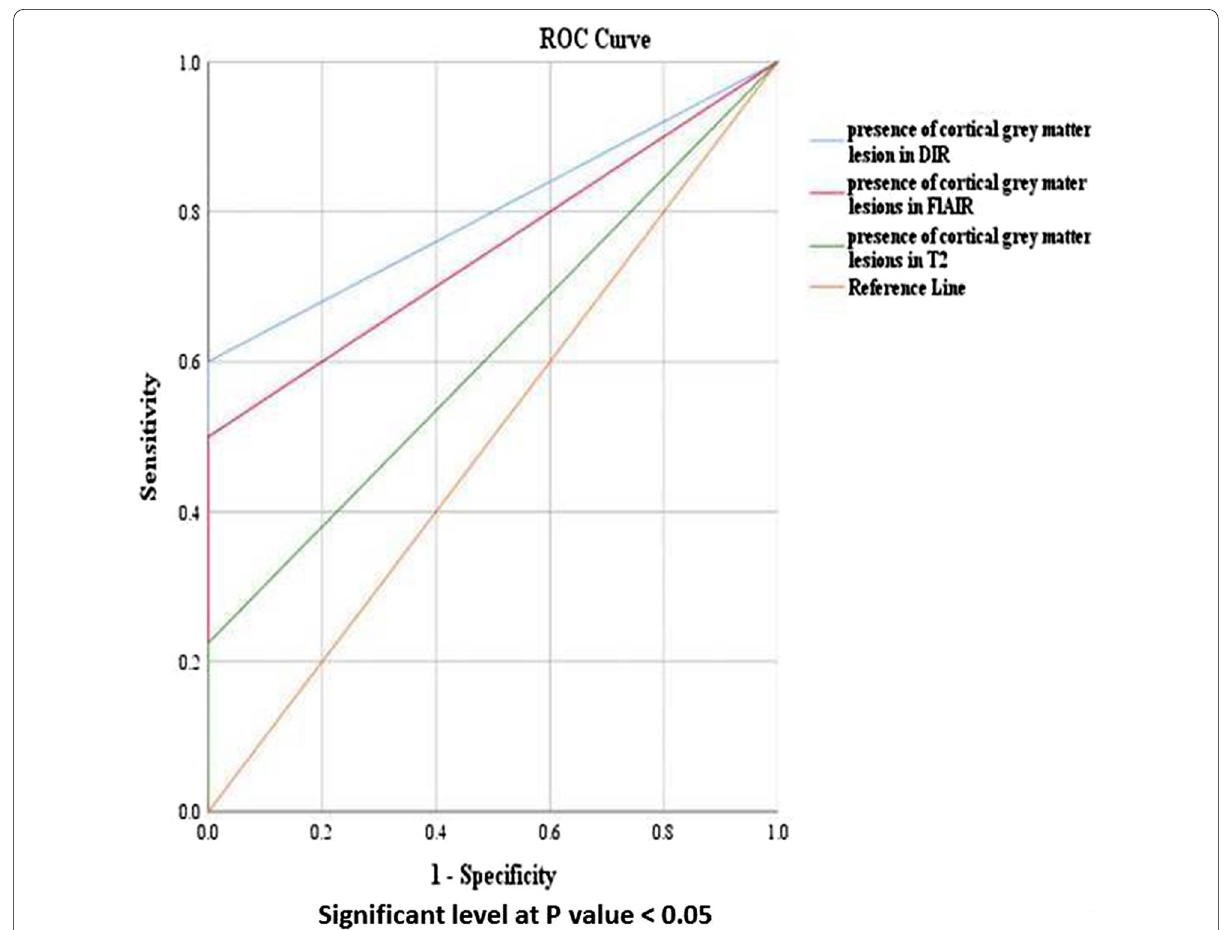
Fig. 1 ROC curve analysis for the prediction of cortical grey matter lesions using different MRI sequences (DIR, Flair and T2) (control group is the reference